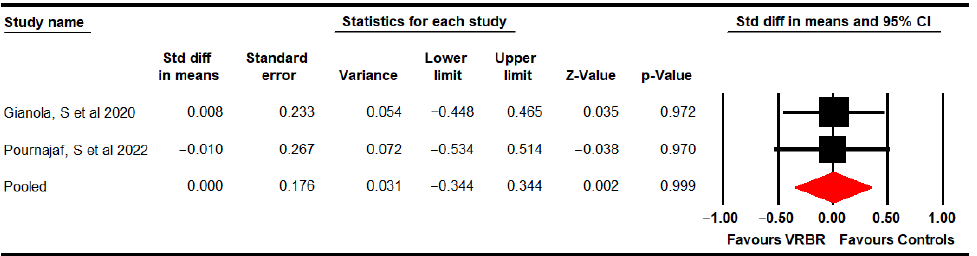
Figure 9. Forest plot of the immediate effect of VRBR on functional independence [65,69].